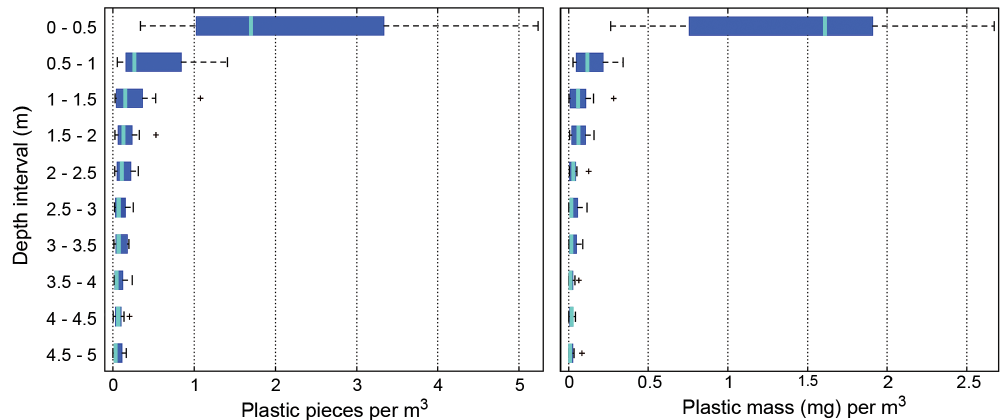
Figure 2. Boxplots of plastic numerical (left) and mass (right) concentrations at different depth intervals ( N = 12 multi-level net tows). The central line is the median value, edges of the box are the 25th and 75th percentiles, whiskers extend to extreme data points not considered outliers, and outliers are plotted individually as crosses.